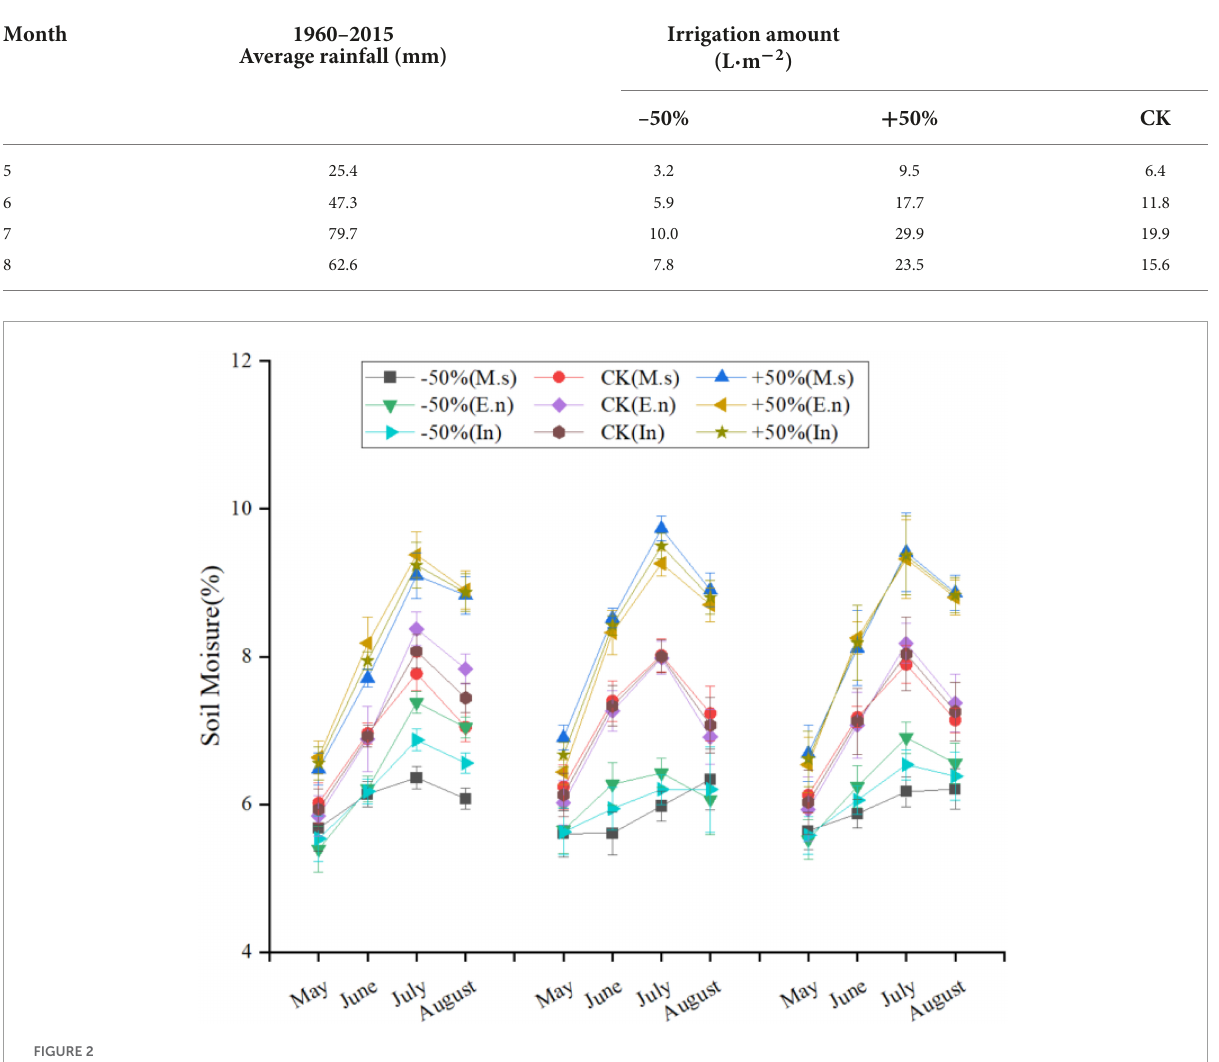
FIGURE2 Soil moisture in May to August from 2015 to 2017 under different water levels.